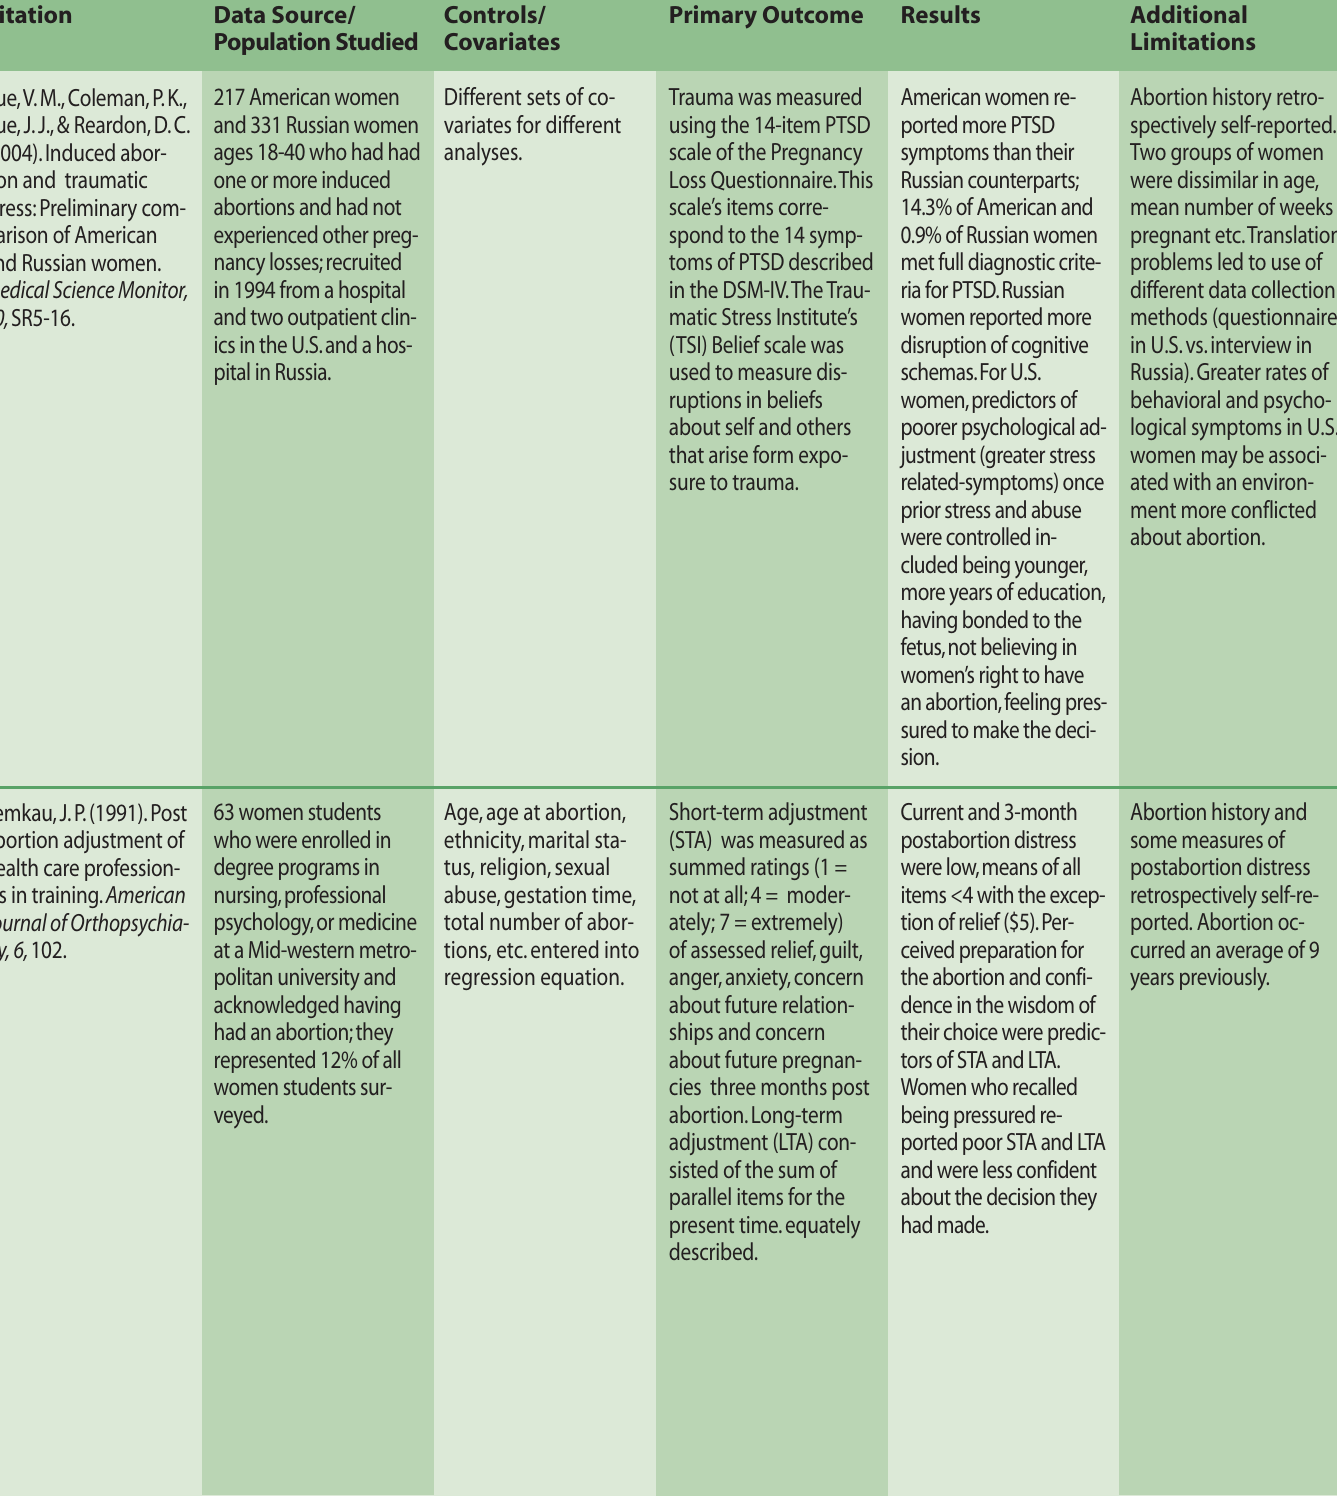
Table 5: U.S.Samples of Abortion Group(s) Only/No Comparison (continued) Retrospective Studies (all these studies lacked a preabortion measure of psychological